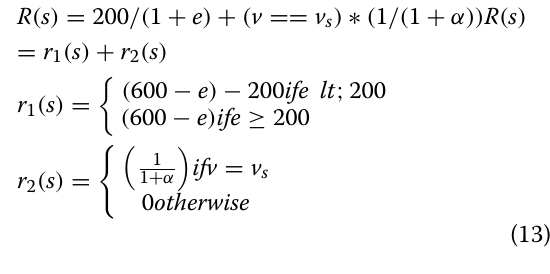
2 PV array under shading ×